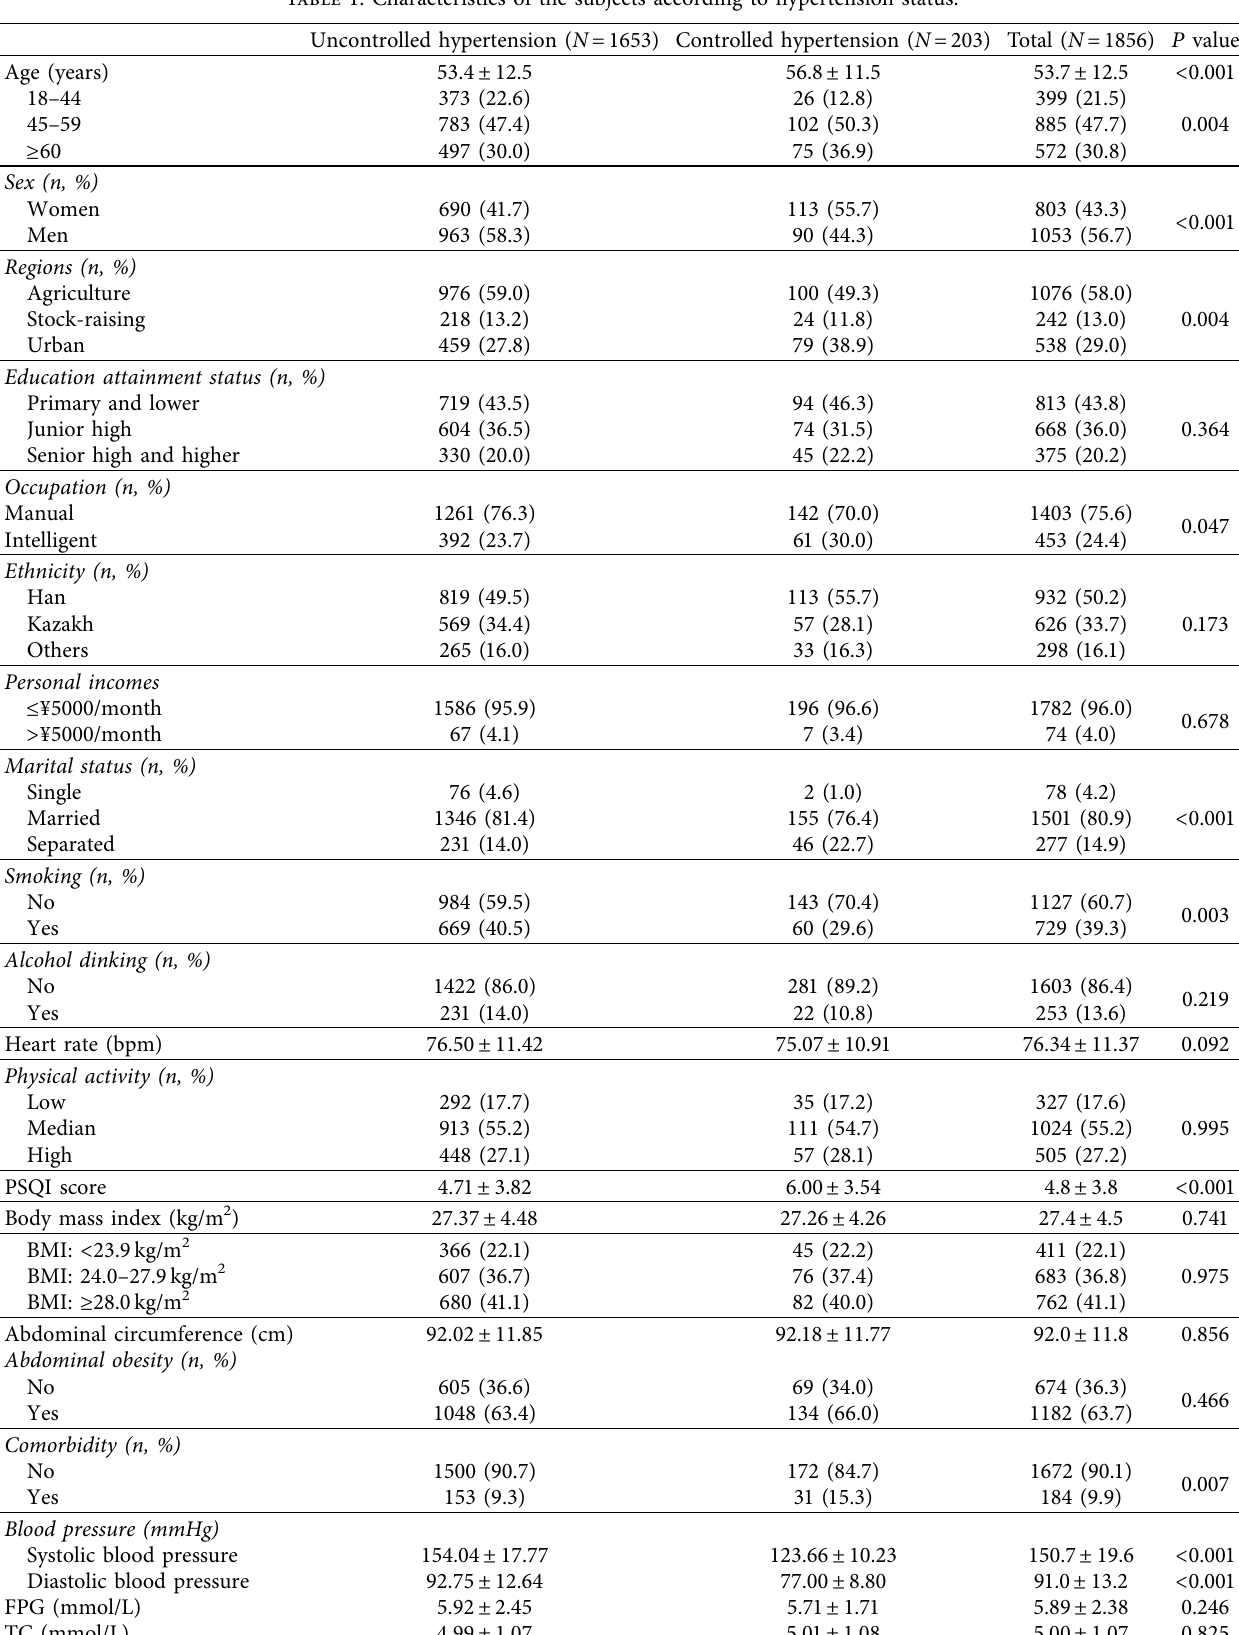
Table 1: Characteristics of the subjects according to hypertension